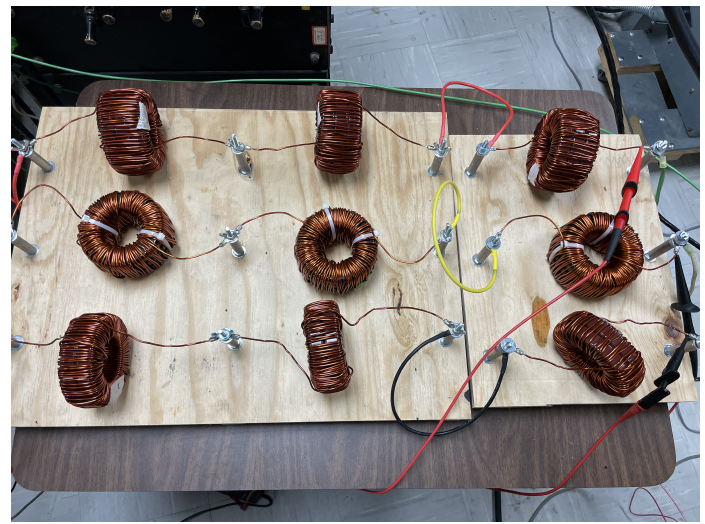
Figure 14. The unbalanced grid inductance with 5.1, 4.5, 3